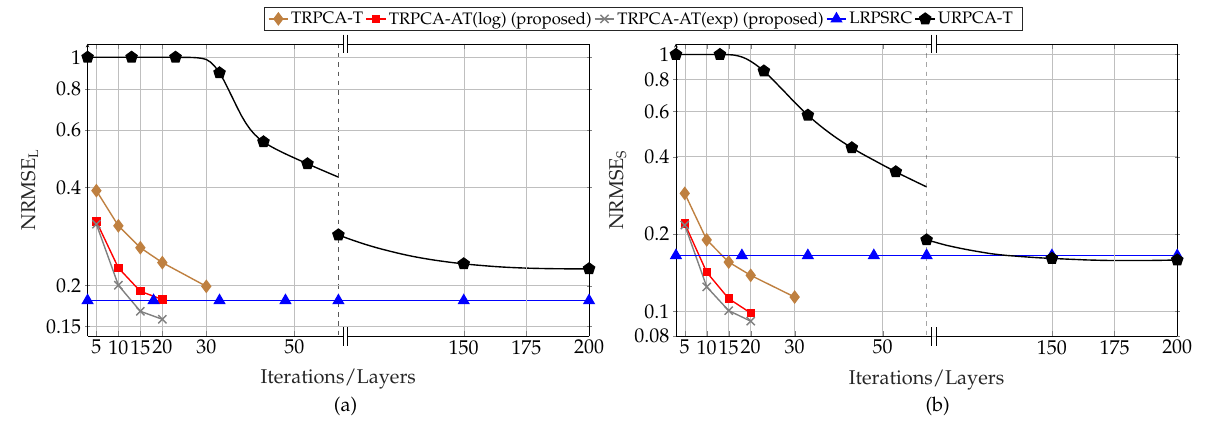
Figure 4. Average recovery error of low-rank ( a ) and sparsity ( b ) contributions for compression ratio K / MN = 25% for ADMM-based trained RPCA with thresholding (TRPCA-T), proposed ADMM- based trained RPCA with adaptive thresholding based on logarithm heuristic (TRPCA-AT(log)), proposed ADMM-based trained RPCA with adaptive thresholding based on exponential heuristic (TRPCA-AT(exp)), low-rank plus sparse recovery with convex relaxation (LRPSRC), and ADMM- based untrained RPCA with thresholding